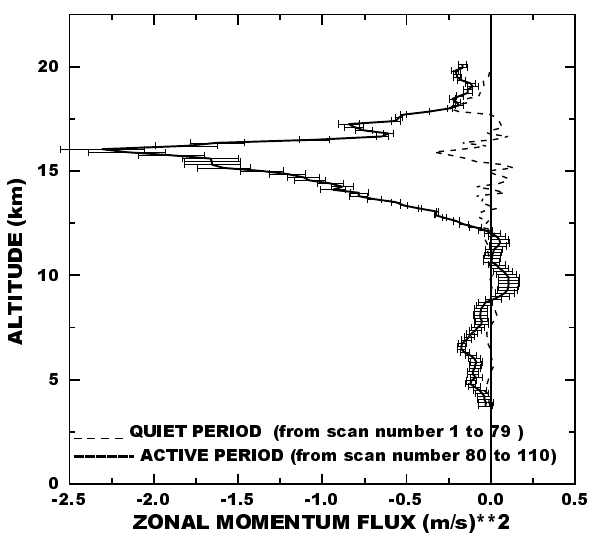
Fig. 14. Tme evolution of meridional momentum flux for 28 August 1999 during 09:00 to